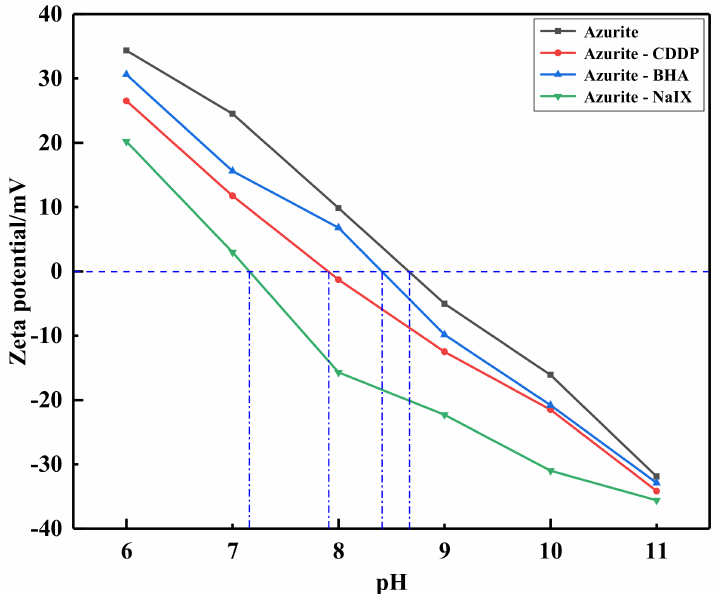
Figure 5. Relationship between the zeta potential of azurite and the pH values before and after the addition of